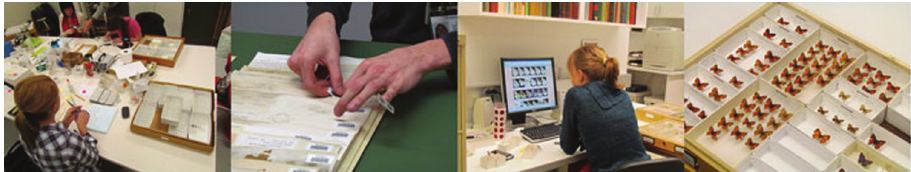
Figure 1. Pre-digitization specimen curation and staging. Preparing barcodes and imaging labels, affixing barcodes, updating taxonomy. L to R: University of Kansas – Entomology, New York Botanical Garden and Yale Peabody